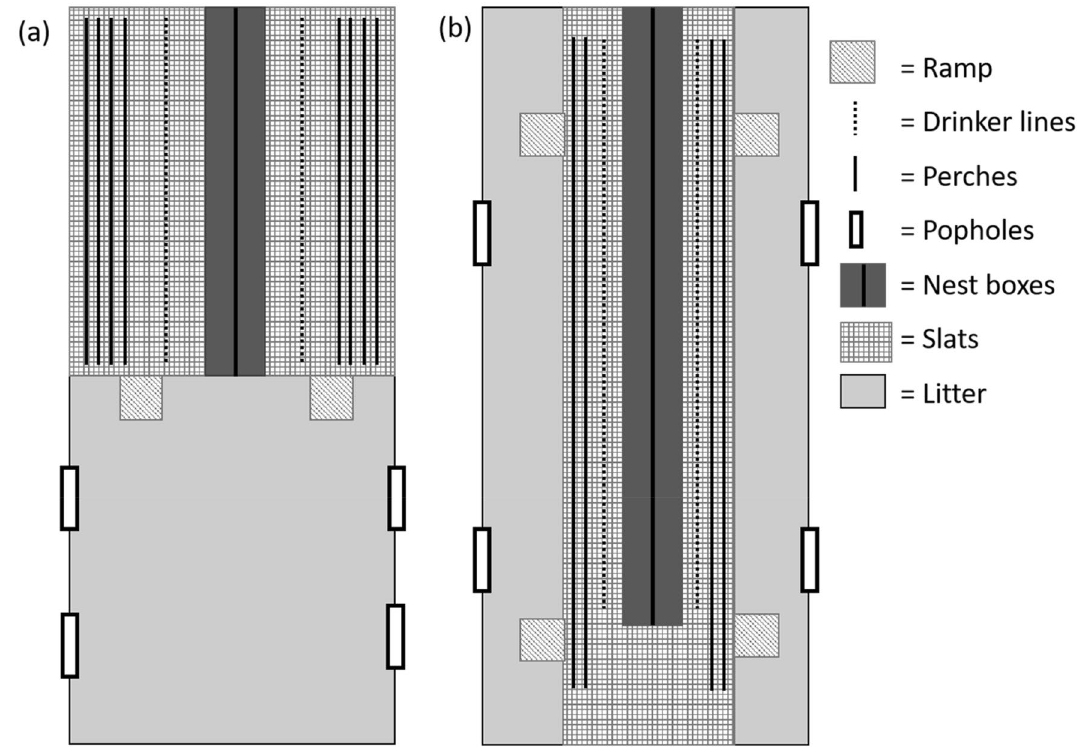
Figure 4. Plan view of the laying house layout (a) for replicates 1, 2, 4 and 5 and (b) for replicates 3 and 6. Images not to scale.